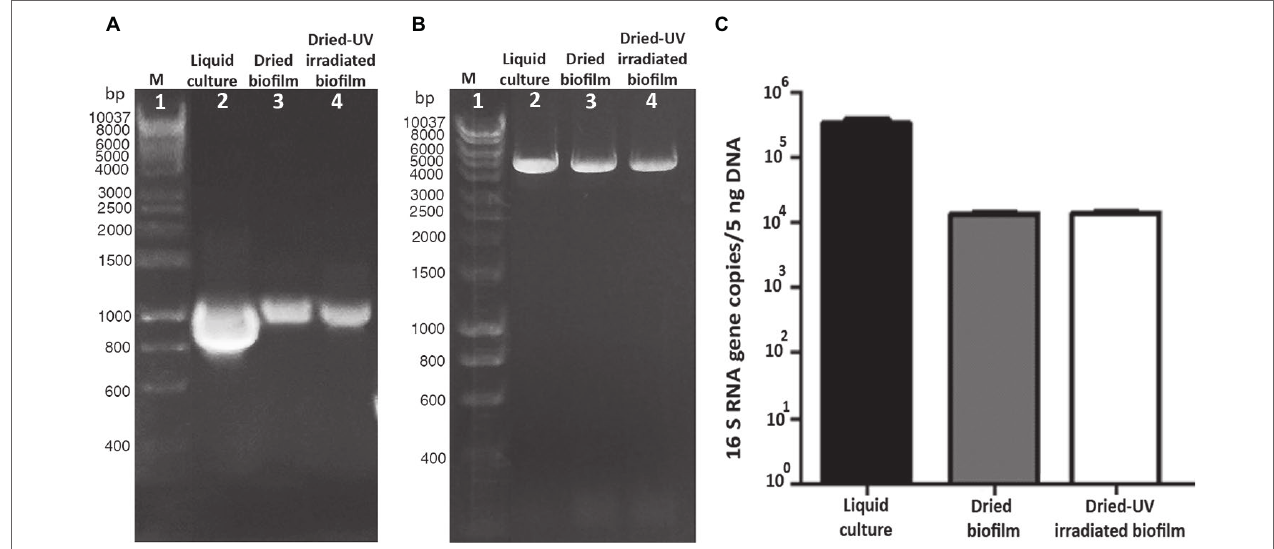
FIGURE 4 | Assessment of DNA damage in cells from liquid culture, dried-biofilm, and dried-UV-irradiated biofilm. PCR amplification of 1,027-bp fragment of the16S rRNA gene (A) and 4-kbp genomic fragment (B) ; lane 2: control cells from liquid culture; lane 3: dried biofilm; lane 4: dried-UV-irradiated biofilm; lane